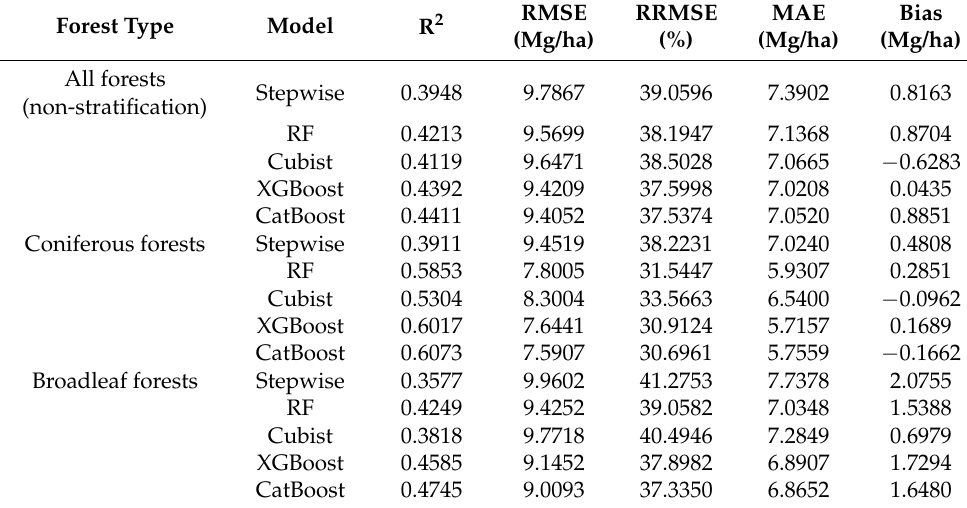
Table 6. Performance of forest AGC estimation model based on non-stratification and FTS in the validation